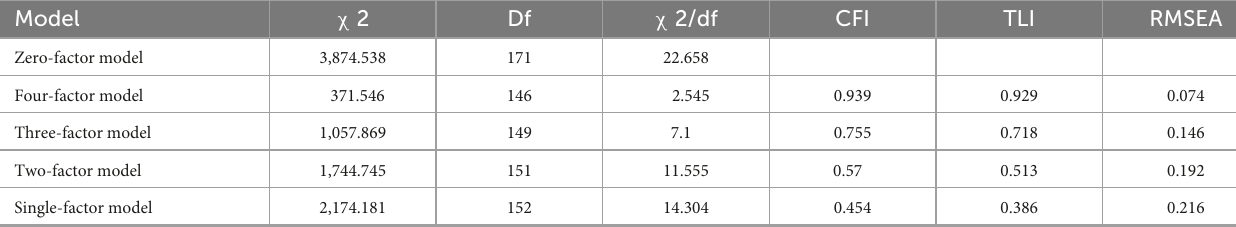
TABLE 1 Results of confirmatory factor